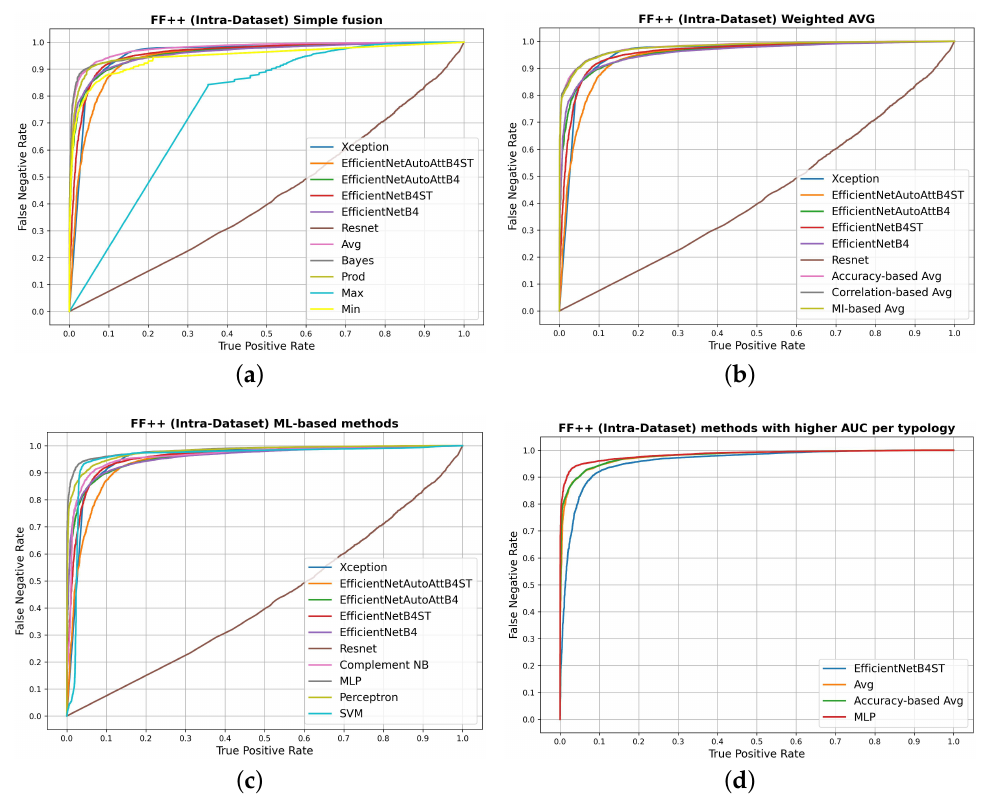
Figure 4. ROC curves on the FF++ dataset comparing the single deepfake detectors with their fusion through non-parametric approaches ( a ), the approaches based on weighted averages ( b ), the ones based on machine-learning models ( c ) and comparing the most performing methods of each category with respect to the obtained AUC ( d